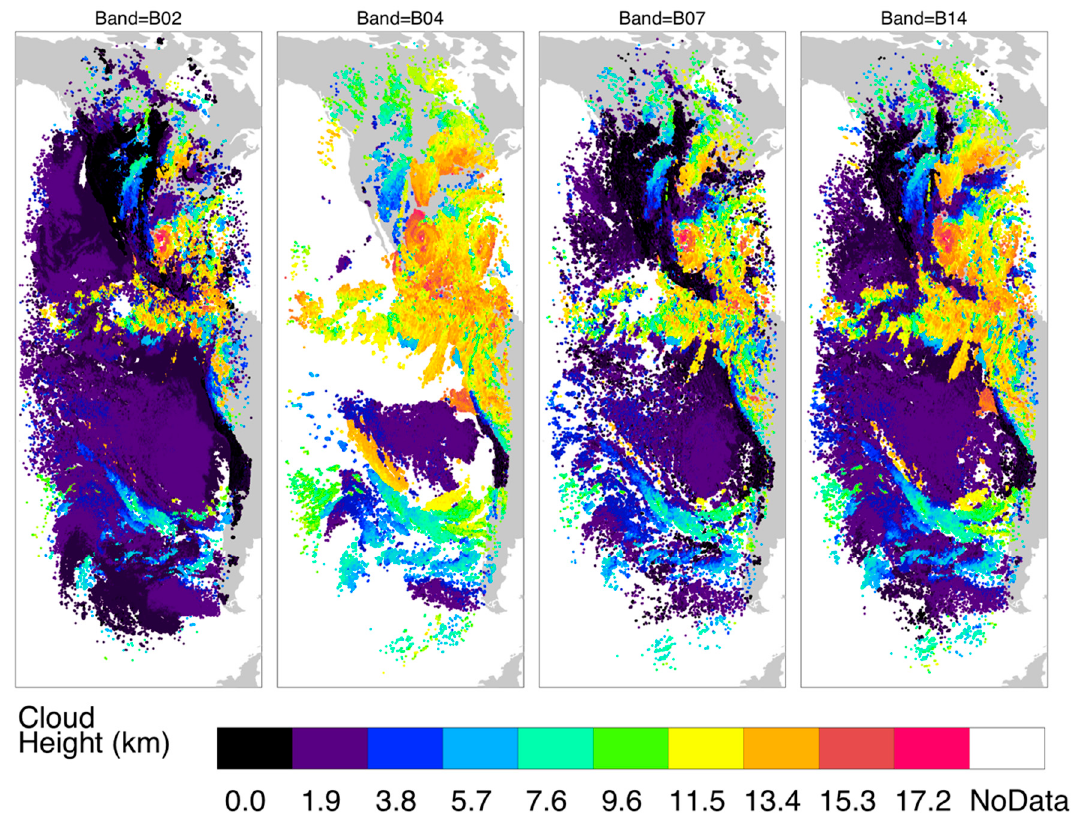
Figure 11. Spatial distribution of FD–FD cloud height retrievals from four GOES-16 and -17 spectral bands on 25 July 2020, 17:20 Z when Hurricane Hanna is evident in the Gulf of Mexico. A 12 pixel × 12 pixel template size and 6 pixel × 6 pixel sampling size are used in the retrieval configuration. A total of 103,744, 97,030, 110,505, and 146,571 good retrievals are produced for Bands 2, 4, 7, and 14, respectively, whereas B02 has a 4 × better resolution than the other bands. Cloud heights greater than 17.2 km are assigned to this maximum value. No cloud masking is applied to stereo height retrievals.